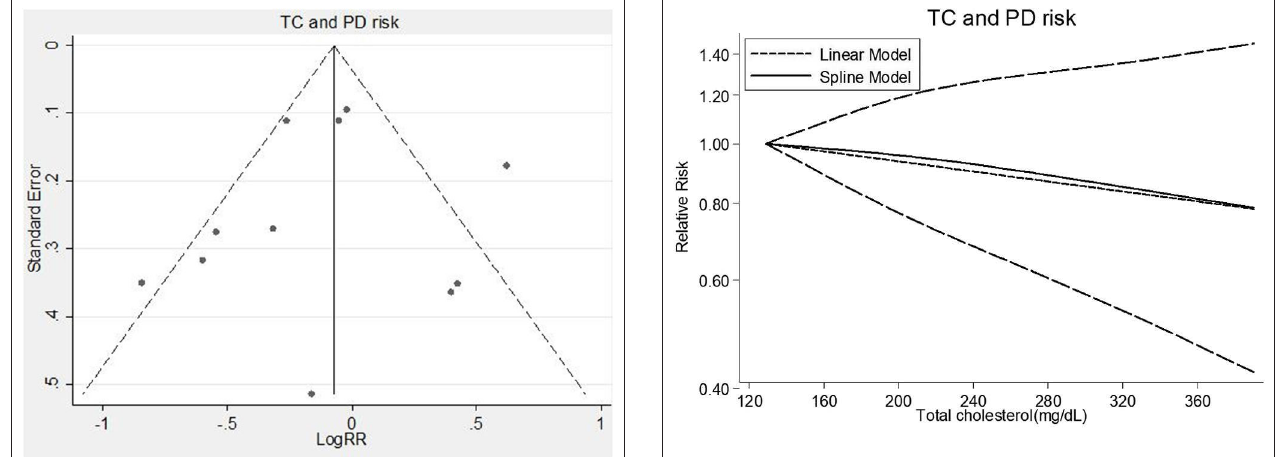
FIGURE 4 | Dose-response relationship between serum TC levels and risk of PD. TC, total cholesterol; PD, Parkinson’s